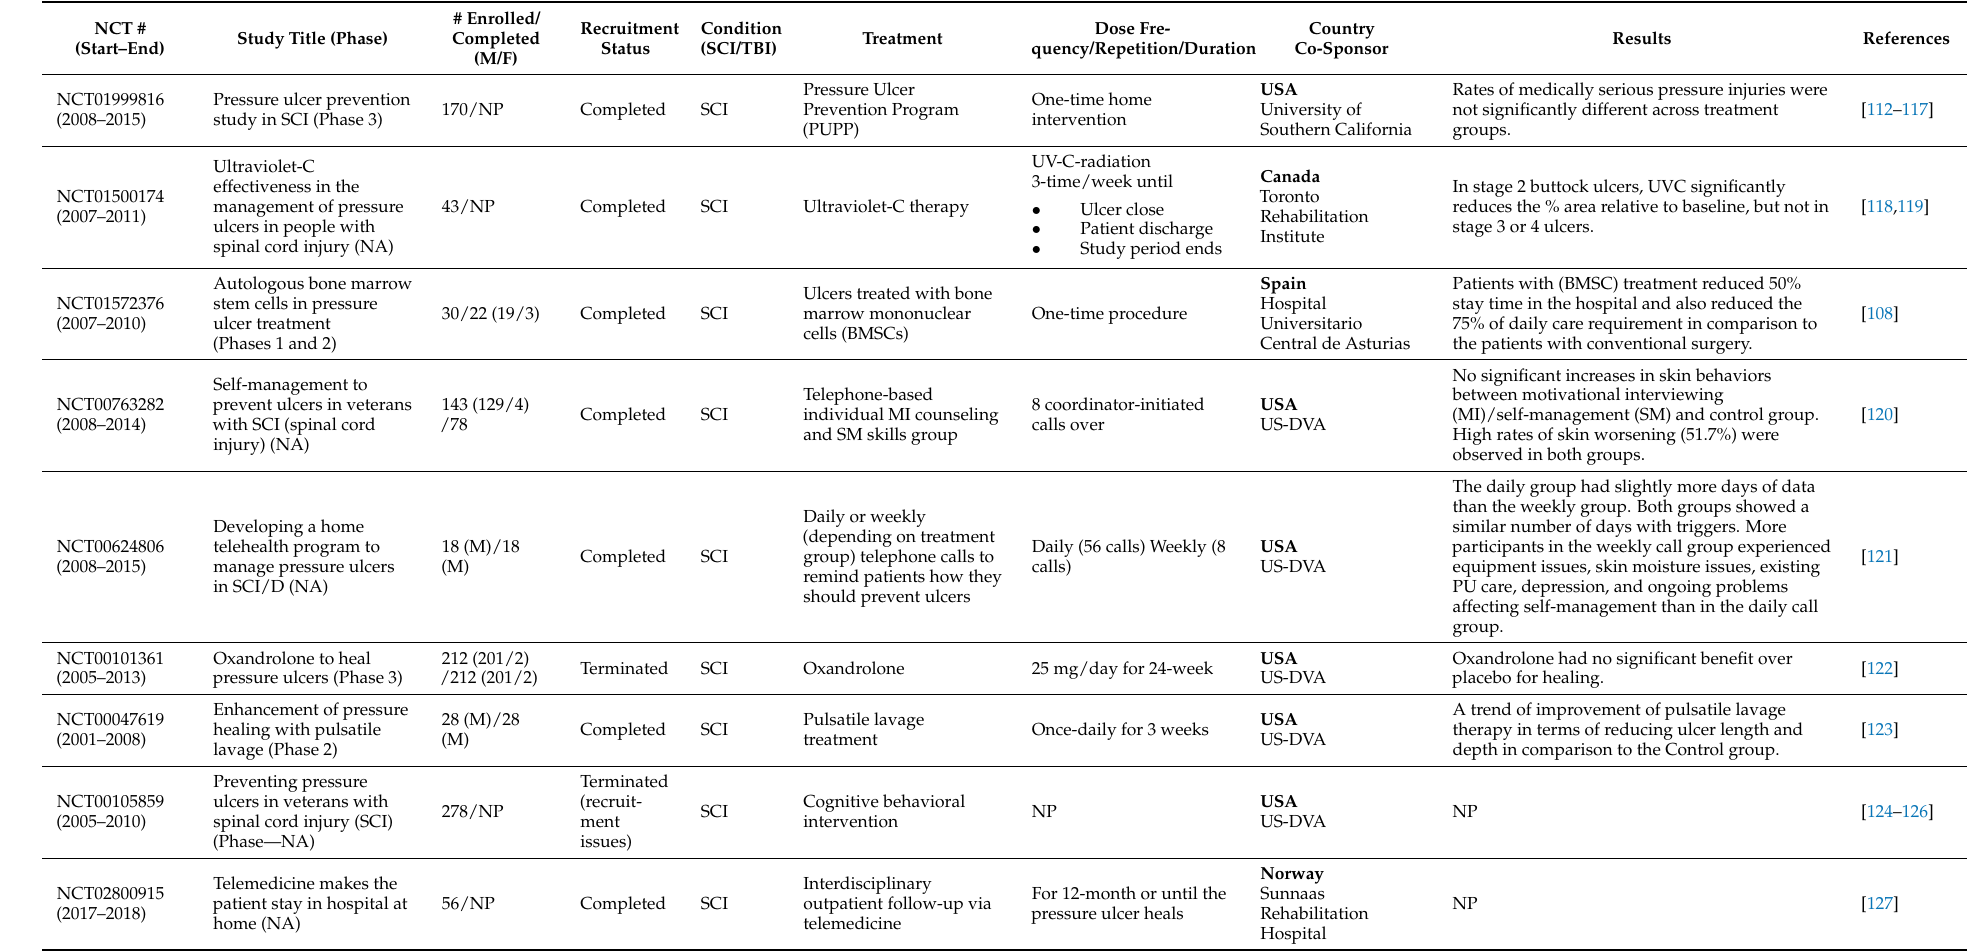
Table 1. Clinical trials for pressure ulcers in the spinal cord injury (SCI) and traumatic brain injury